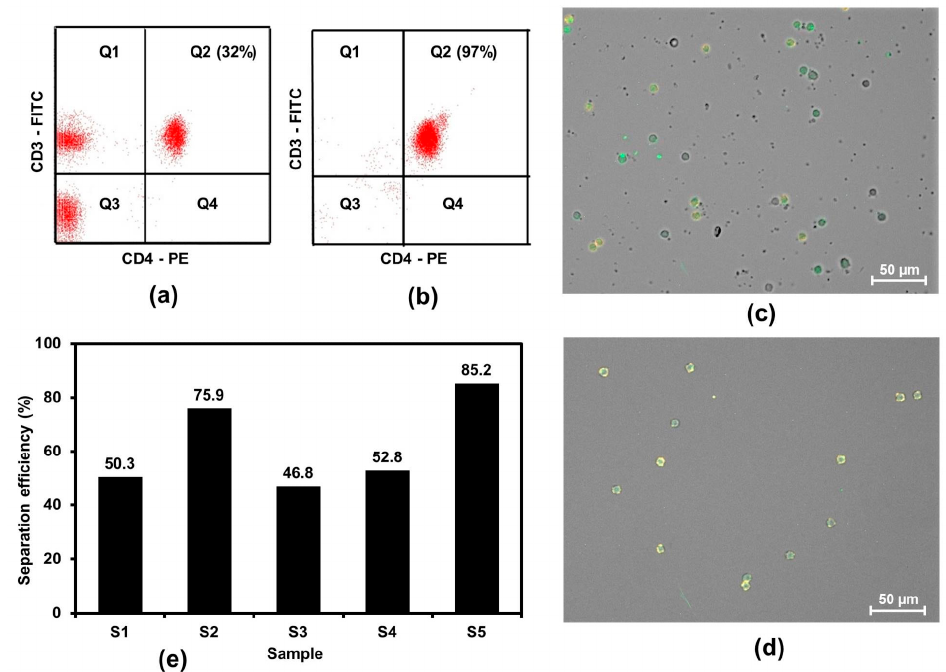
Figure 1. Separation of CD4 + T cells from peripheral blood mononuclear cells (PBMC) using the conventional method. Representative images of FACS analysis data showing the percentage of CD4 + T cell population (Q2) in the PBMCs from sample S1 ( a ) before and ( b ) after separating the CD4 + T cells using NP-CD4 and the Dynamag™-2 magnet (the lymphocyte is gated and colored red). Representative merged images showing cells stained with CD4-FITC (green color) and CD3-PE (red color) ( c ) before and ( d ) after separation was observed under a fluorescence microscope at 20 × magnification. ( e ) Cell separation efficiencies from five PBMC samples (S1–S5).